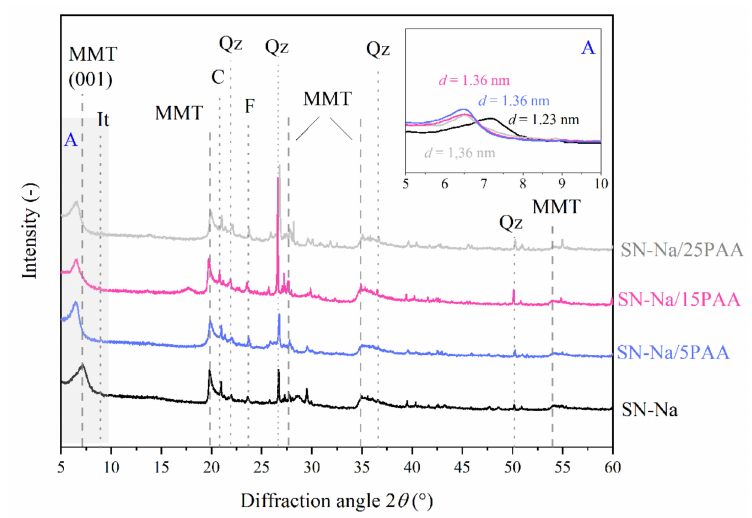
Figure 7. X-ray diffraction patterns of sodium bentonite SN-Na and modified with poly(acrylic acid) bentonite SN-Na/PAA with distinction into the polymer content (MMT—montmorillonite, It—illite, C—calcite, Qz—quartz, F—feldspar). The A area is a magnification of the XRD pattern in the angle range of 5–10 ◦